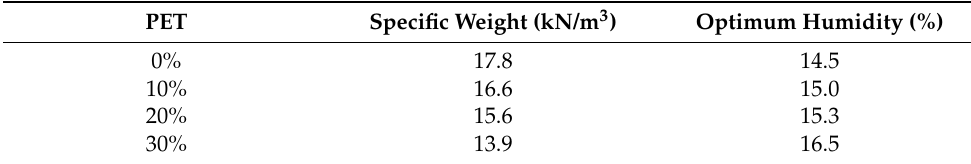
Table 3. Optimum compaction humidity and maximum mixture densities.